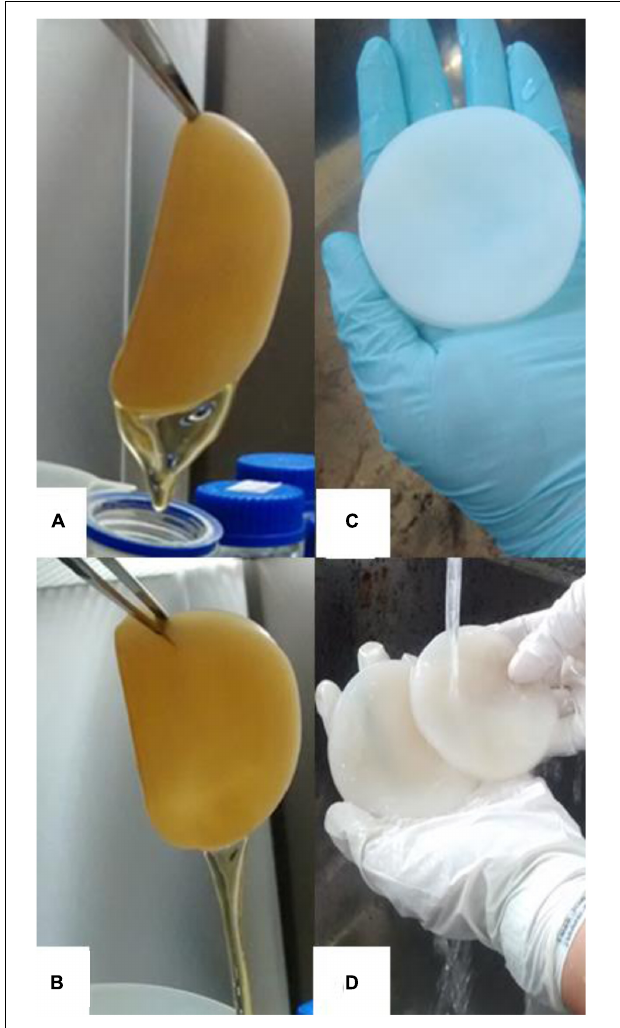
FIGURE 1 | Macrograph of bacterial cellulose (BC) pellicles composed by nanofibrils and water produced after 10 days of static cultivation in Hestrin–Schramm (HS) medium (A) and in alternative medium (B) . Pellicles produced before (A,B) and after NaOH treatment to remove G. hansenii biomass (C,D) .